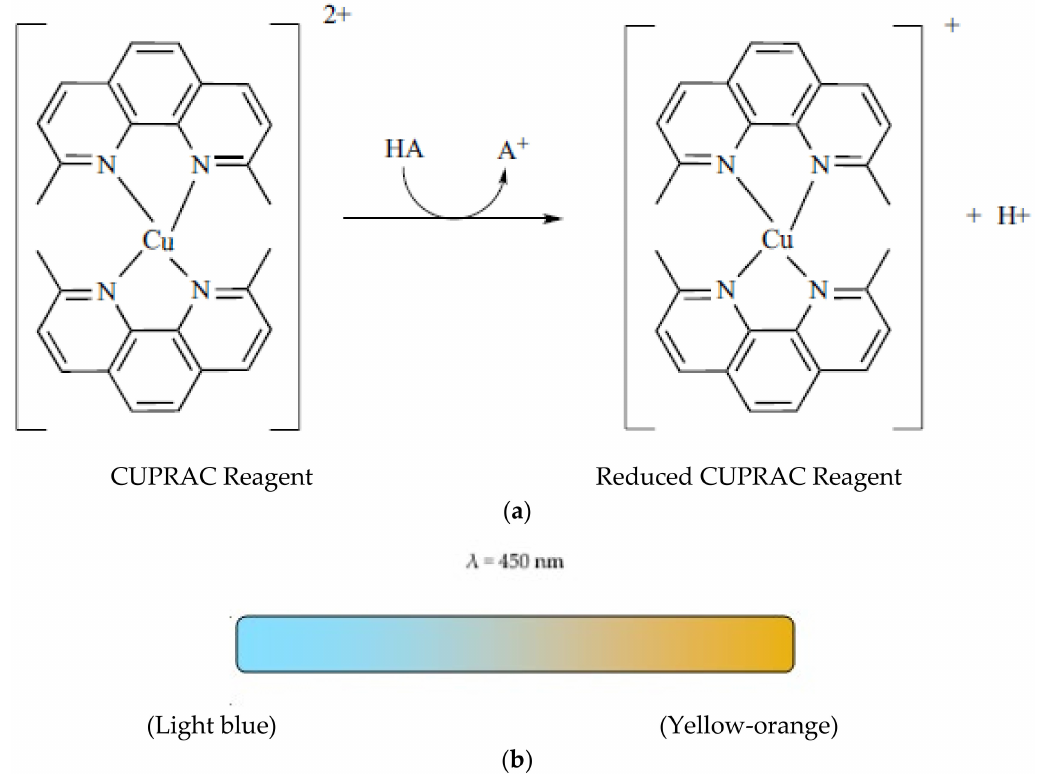
Figure 5. Reaction scheme involved in Cupric Reducing Antioxidant Power (CUPRAC) assay. HA represents an antioxidant molecule and A + an oxidised antioxidant molecule ( a ); Colour change in the assay ( b